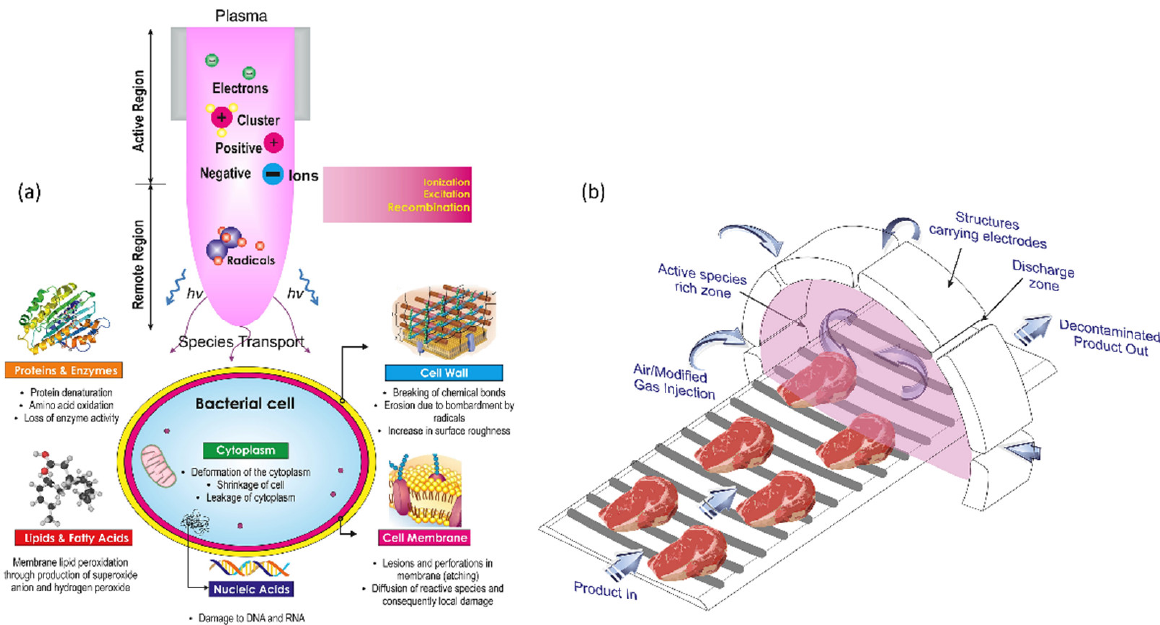
Figure 7. ( a ) A diagram depicting the action of NTP on bacterial cell structures, resulting in functional loss and sterilization. ( b ) Conceptual model for an industrial-level continuous NTP disinfecting unit. Reprinted with permission from Ref. [106]. Copyright 2017, Elsevier.